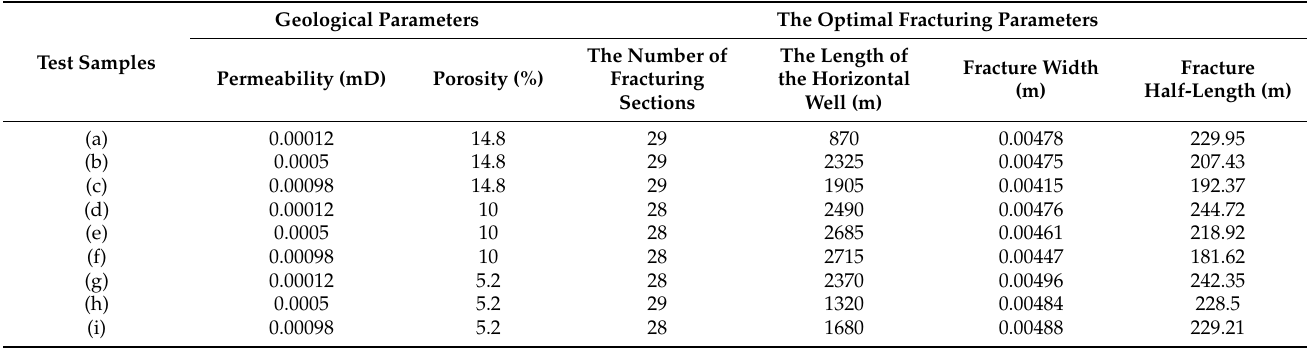
Table 5. The optimal fracturing parameters of the nine test samples.